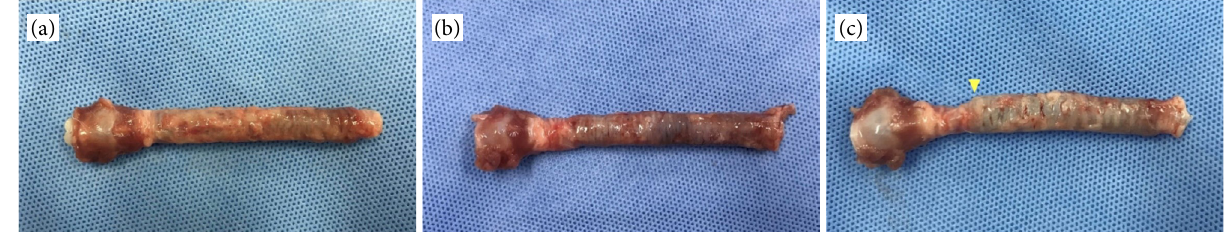
Figure 8 - Harvested tracheal samples of rabbits with each type of self-expanding metal stent. (a) The S-type stent with a wire diameter of 0.006 inches. (b) The D-type stent with a wire diameter of 0.006 inches. (c) The D-type stent with a wire diameter of 0.007 inches. The tracheal diameters of (a) and (b) were consistent throughout the trachea. The yellow arrowhead in (c) indicates the area in which the tracheal cartilage is stretched due to the high radial force of the stent.